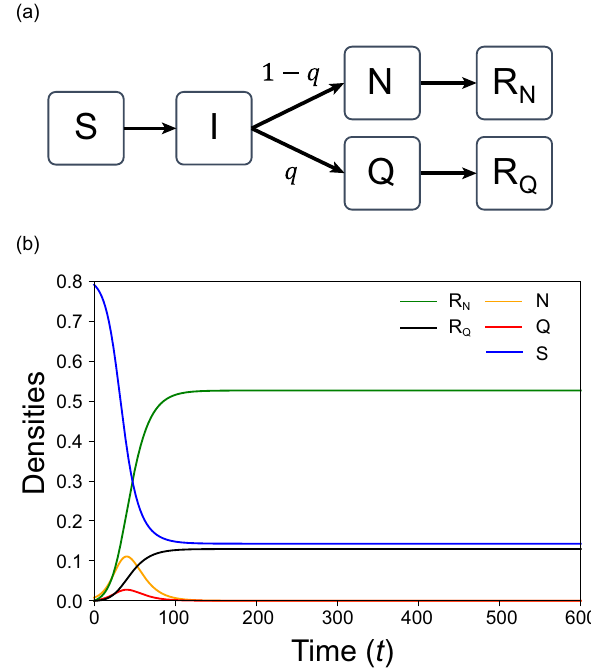
Figure 1. Model and population dynamics. ( a ) Schematic illustrations of infection model. ( b ) Predictions of mean-field theory (MFT) which agree with the simulation results of global interaction. In the present article, we put ρ 0 = 0.2 and the initial condition is set as follows: ( S , N ) = (0.792, 0.008) and the other densities are zero at t = 0. Values of parameters in all figures are listed in Table